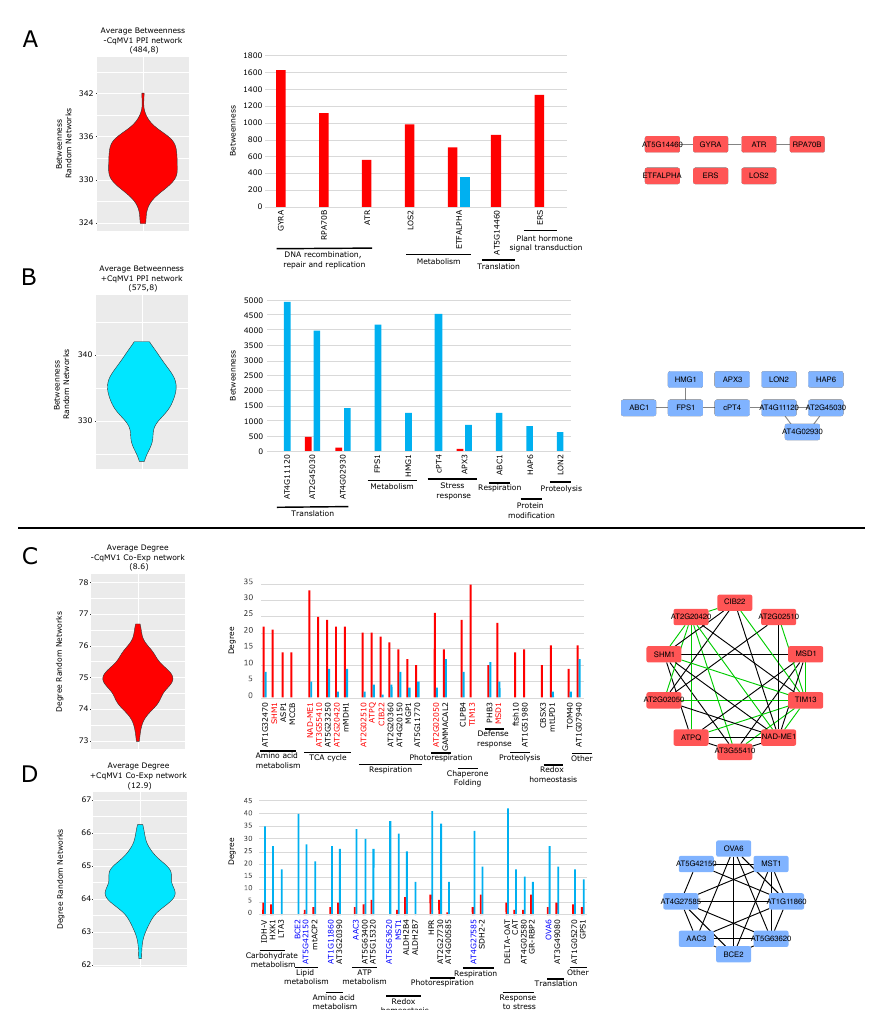
Figure 5. Protein–protein interaction (PPI) and co-expression (Co-Exp) network hubs. PPI hubs in − CqMV1 ( A , B ) +CqMV1 network models. Violin plots show average betweenness in − CqMV1 (in red) and +CqMV1 (in blue) PPI random network models. Selected hubs are functionally grouped and sorted by descending betweenness. Hubs in − CqMV1 ( C , D ) +CqMV1 co-expression network models. Violin plots show average degree in − CqMV1 (in red) and +CqMV1 (in blue) Co-Exp random network models. Selected hubs are functionally grouped and sorted by descending degree. Red and blue highlighted gene names indicate best hubs (selected by high stringent criteria) in − CqMV1 and +CqMV1 Co-Exp networks, respectively. Red and blue highlighed nodes represent Co-Exp hubs defined “best”, while green network edges indicate negative correlations. Table 2. Proteins both differentially expressed and hubs in − CqMV1 (in red) and +CqMV1 (in blue). Differential Expression PPI HUBS Co-Exp